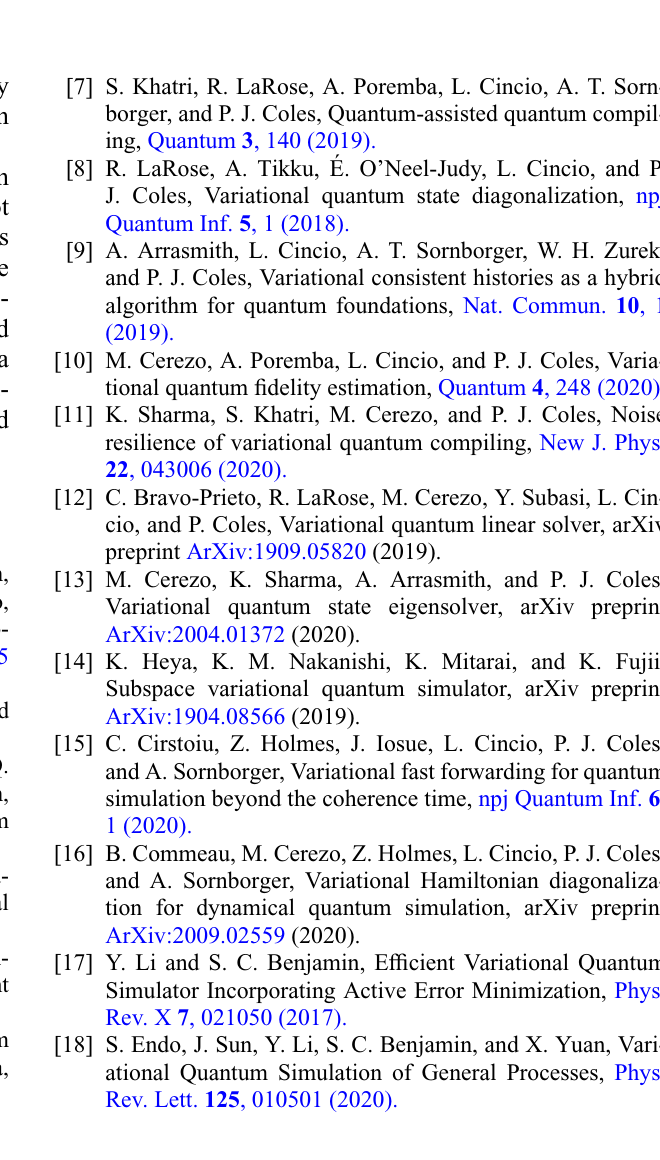
FIG. 8. Correlations between cost partial derivative and the Hamiltonian -dependent frame potential. The setting here is entirely equivalent to that described in Fig. 7; however, here we plot the variance in the partial derivative as a function of the ratio of / F ( H ) and the derivative is taken with respect to θ 1 Hamiltonian -dependent frame potentials F ( H ) Haar L 1